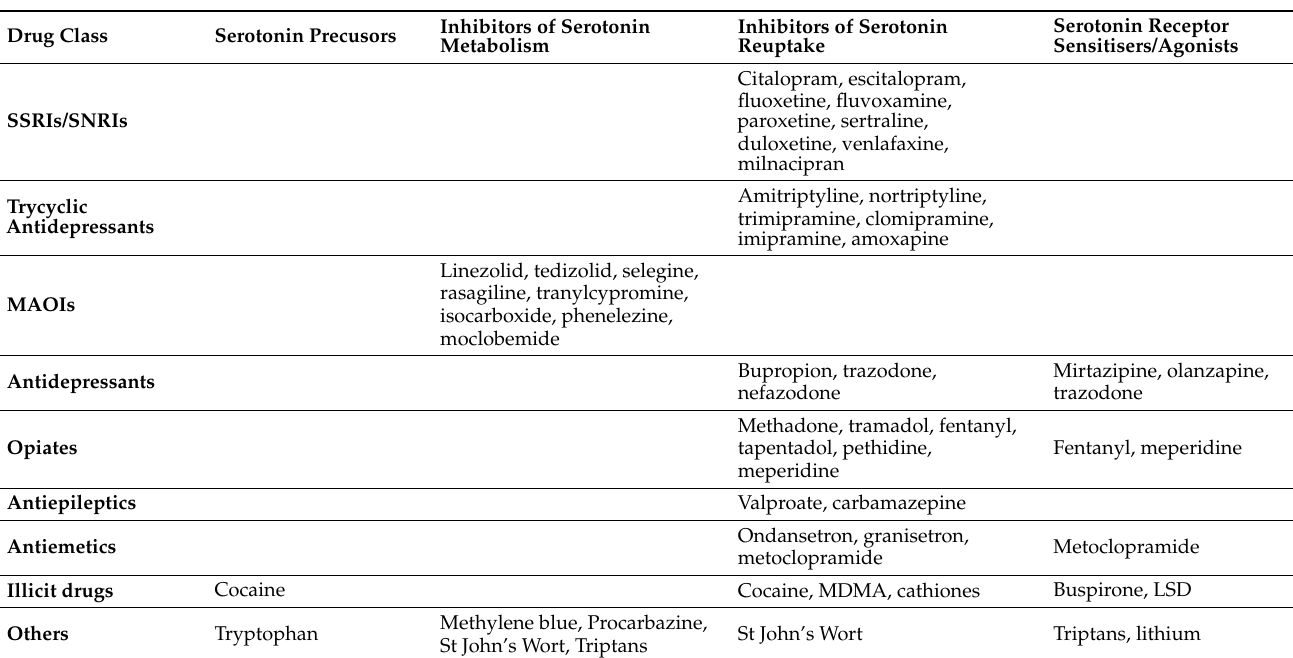
Table 1. Classes of drugs and mechanism of action associated with